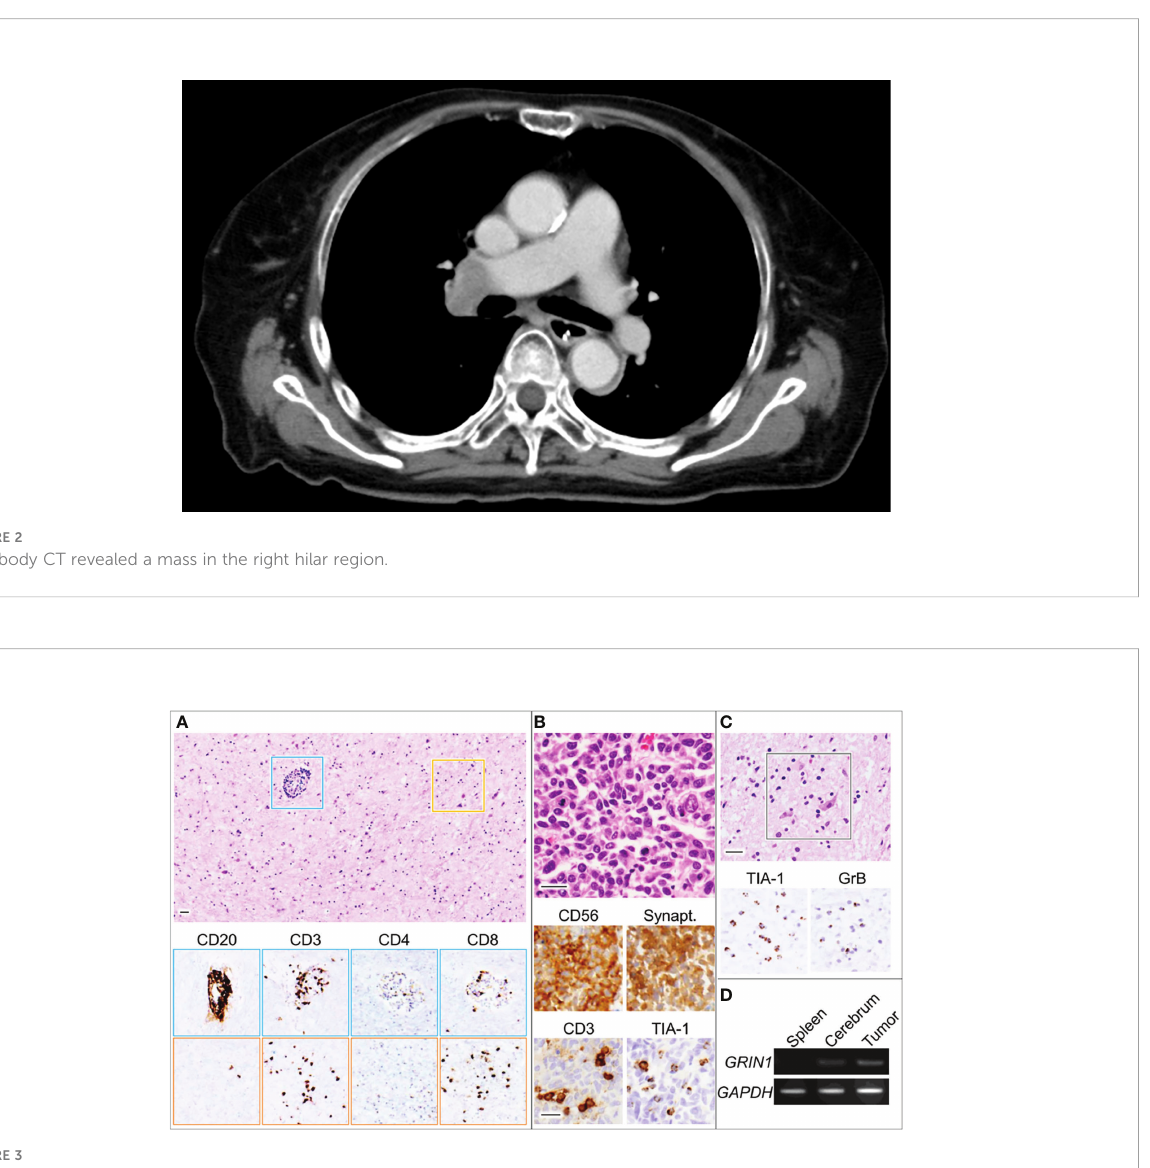
FIGURE 3 Microscopic images for the globus pallidus (A, C) and lung tumor (B) . Blue and orange squares indicate perivascular regions and parenchyma with neurons, respectively. Bars, 50 m m. (D) RT-PCR using total RNA derived from the indicated organs of the patient (D) . GAPDH, glyceraldehyde 3-phosphate dehydrogenase; GrB, granzyme B; GRIN1, glutamate ionotropic receptor N-methyl-D-aspartate type subunit 1; Synapt, Synaptophysin; TIA-1, T-cell intracytoplasmic antigen-1.